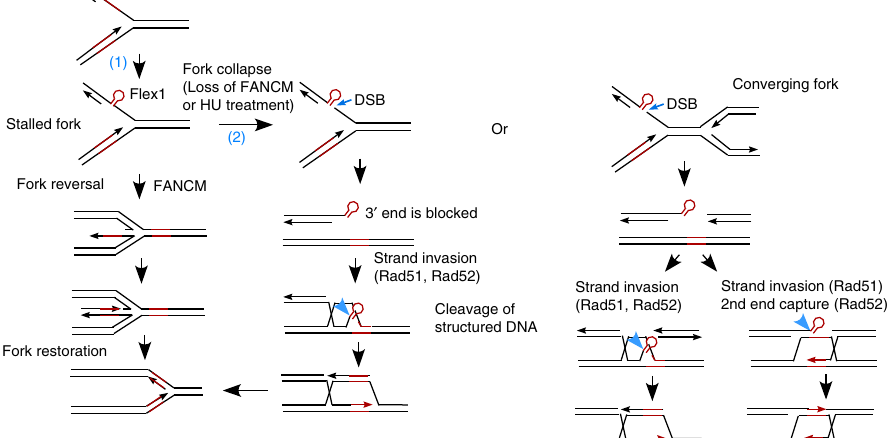
Fig. 7 Proposed model for concerted roles of FANCM and Rad52 in protecting Flex1. Blue-marked (1) and (2) refer to pathway 1 (FANCM-mediated fork reversal to remove DNA secondary structures) and pathway 2 (Rad51/Rad52-dependent HR to repair DSBs accumulated at structure-prone DNA sequences when FANCM is de fi cient), respectively. See Discussion for more details